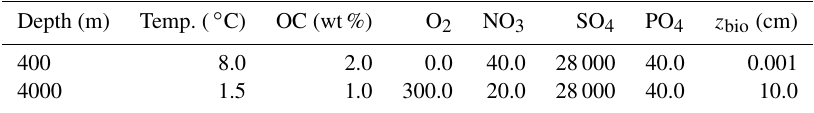
Table 12. Model boundary conditions for the two idealised sediment conditions used for the sensitivity analysis (Figs. 5 and 6). All solute concentrations are in nmolcm − 3 .